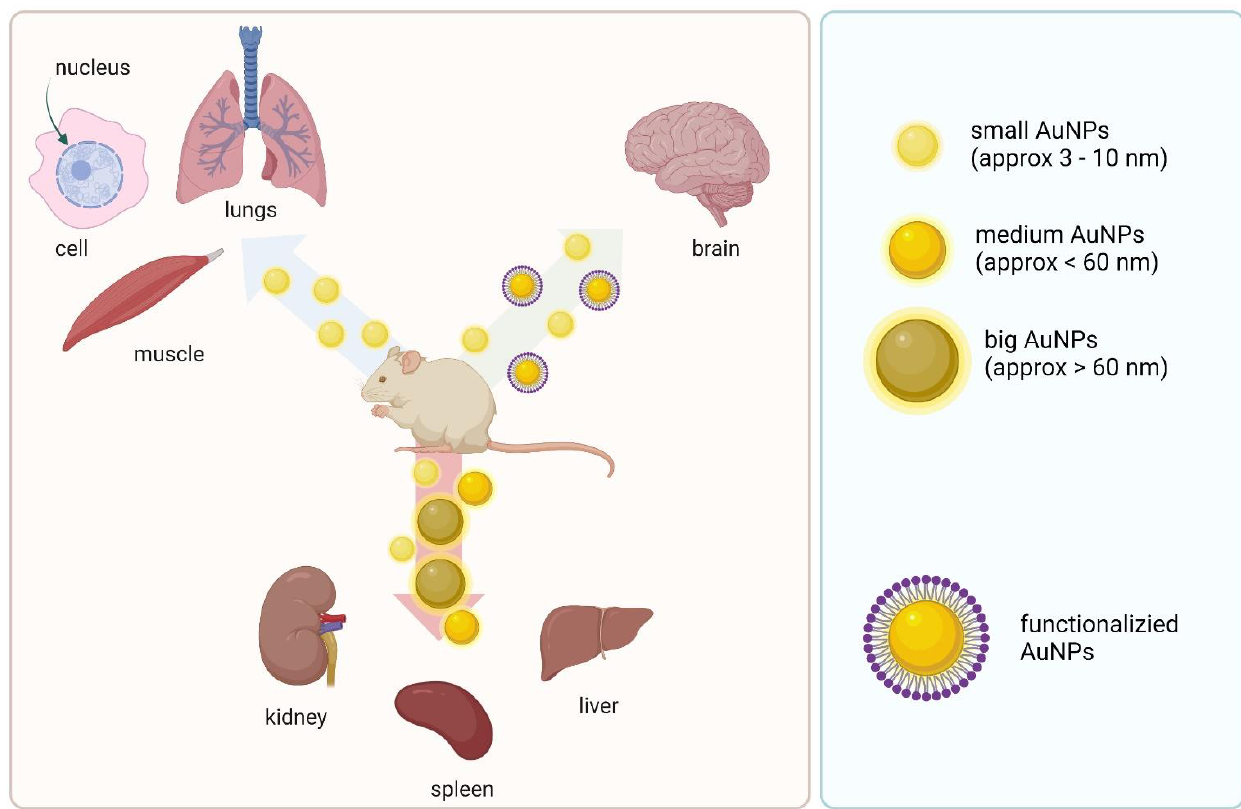
Figure 2. Biodistribution of different size gold nanoparticles.